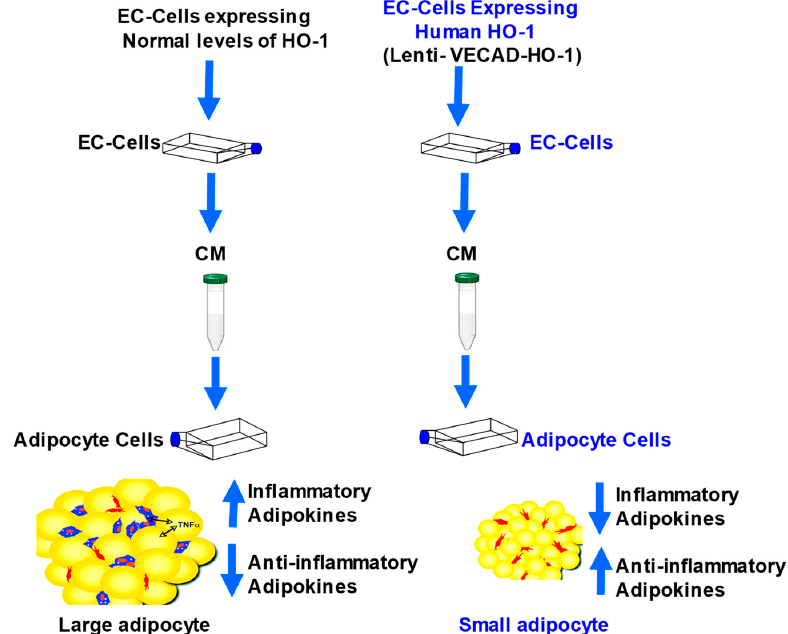
Figure 7. Scheme illustrating the sustained effect of VECAD-HO-1, CM from EC-transfected with HO-1 release substances that increase healthy adipocytes, while CM from control EC add to adipocyte culture, increases adipogenesis and large unhealthy adipocytes.